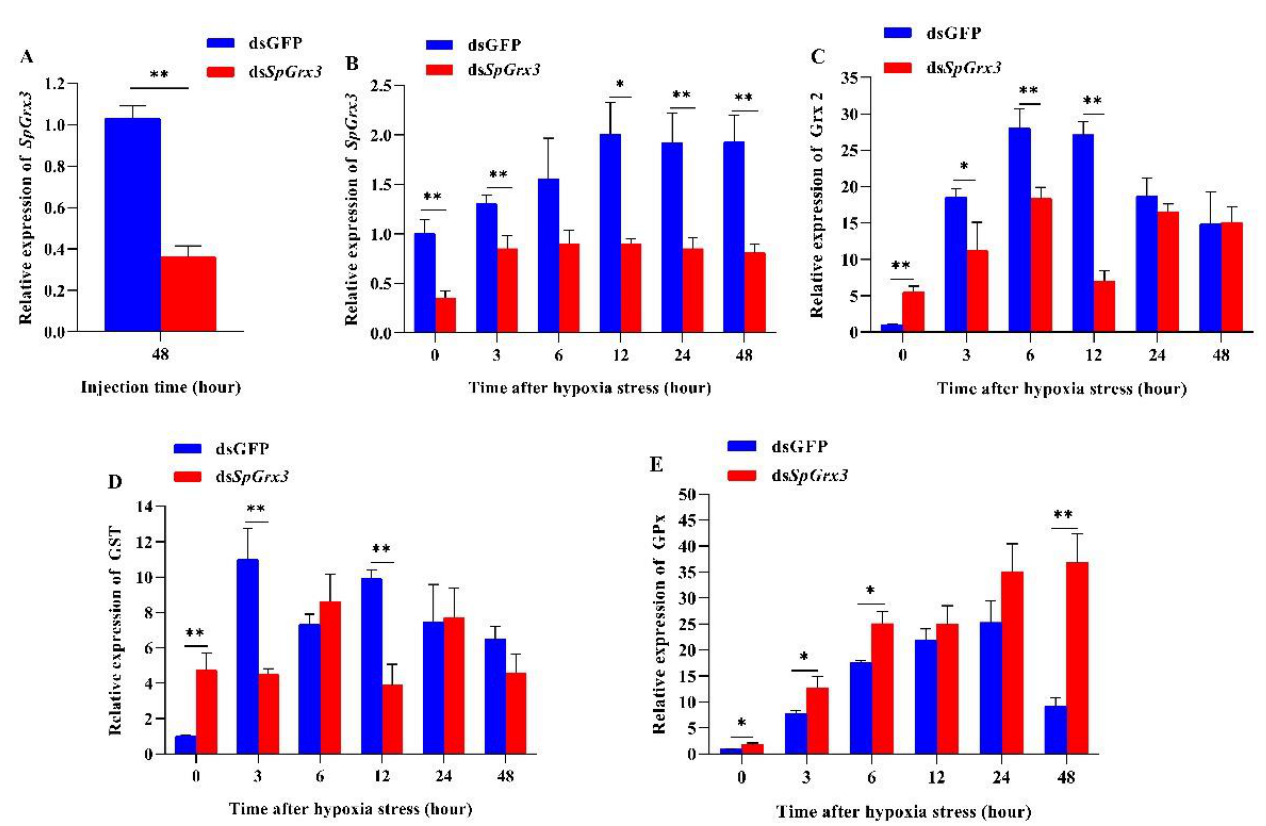
Figure 5. Effects of SpGrx3 silencing on the expression of antioxidant-related genes. ( A ) Silencing efficiency of SpGrx3 in the gills after dsRNA injection. Relative expression levels of SpGrx3 ( B ), Grx2 ( C ), GST ( D ), and GPx ( E ) in the gills of SpGrx3 -interfered mud crabs following hypoxia. Data are presented as the mean ± SD (N = 3). *: p < 0.05, **: p < 0.01.